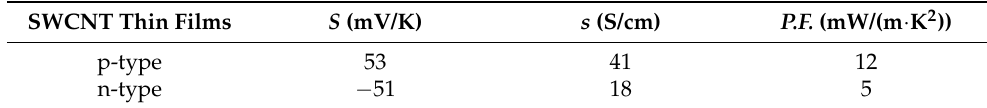
Table 1. In-plane thermoelectric properties of p- and n-type SWCNT films. SWCNT Thin